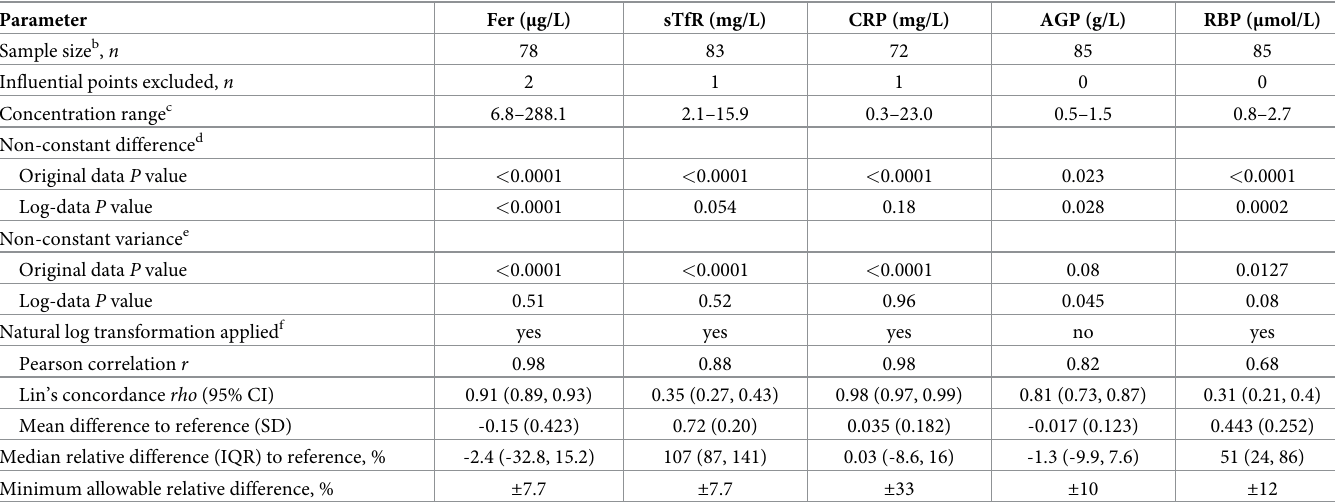
Table 2. Agreement between Q-Plex and reference assay for serum samples a